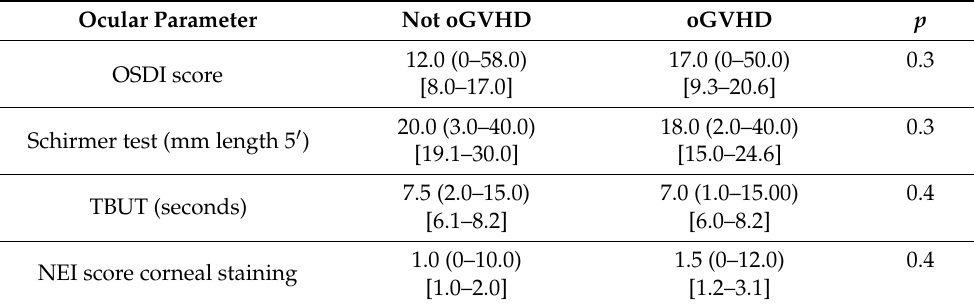
Table 2. Summary of ocular parameters analyzed in patients with or without oGVHD post-hemopoietic stem cell transplant (HSCT). Data are expressed as median (min-max) [95% CI]. OSDI = Ocular Surface Disease Index; NEI = National Eye Institute.